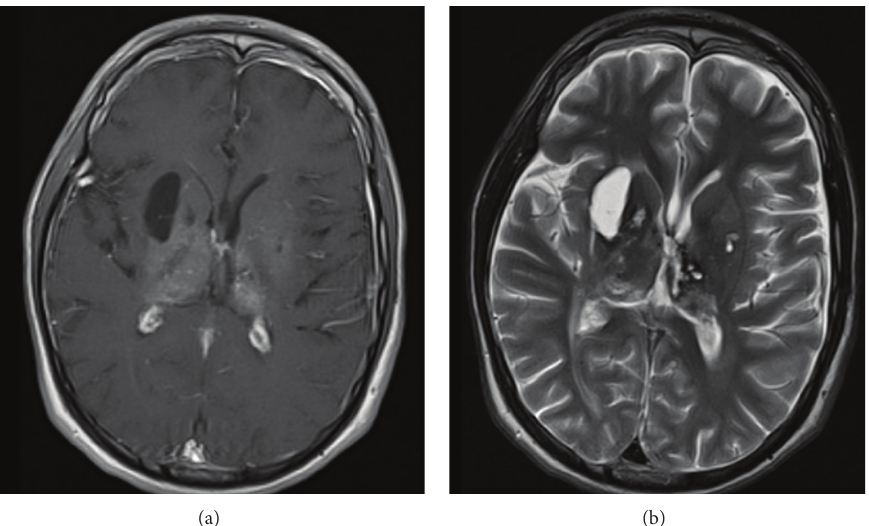
Figure 6: MRI 10 months after radiation treatment. (a) T1-weighted, axial, gadolinium-enhanced image at level of foramen of Monro. (b) T2-weighted, axial image at same